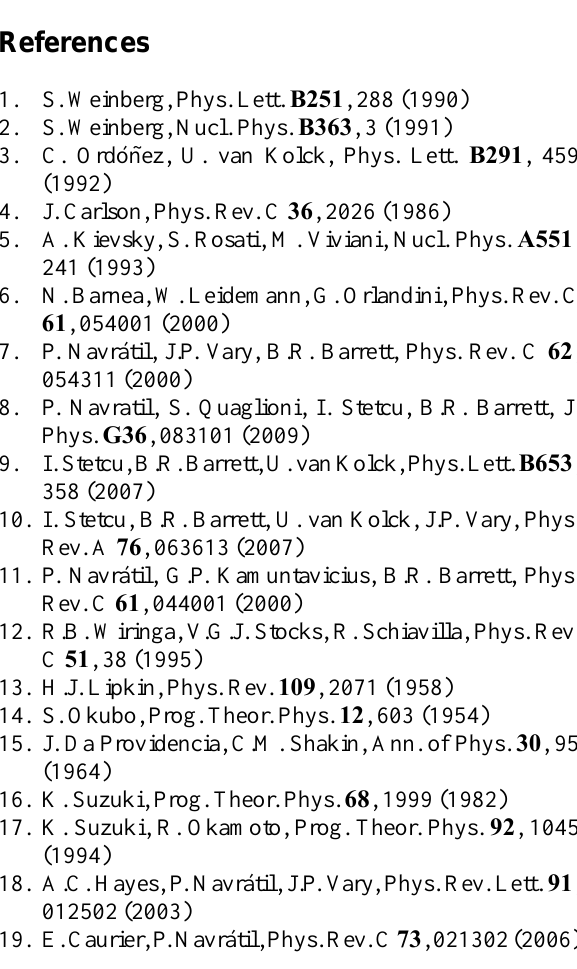
Fig. 5. Same as in Fig. 4, but for r 2 / b = 0 .